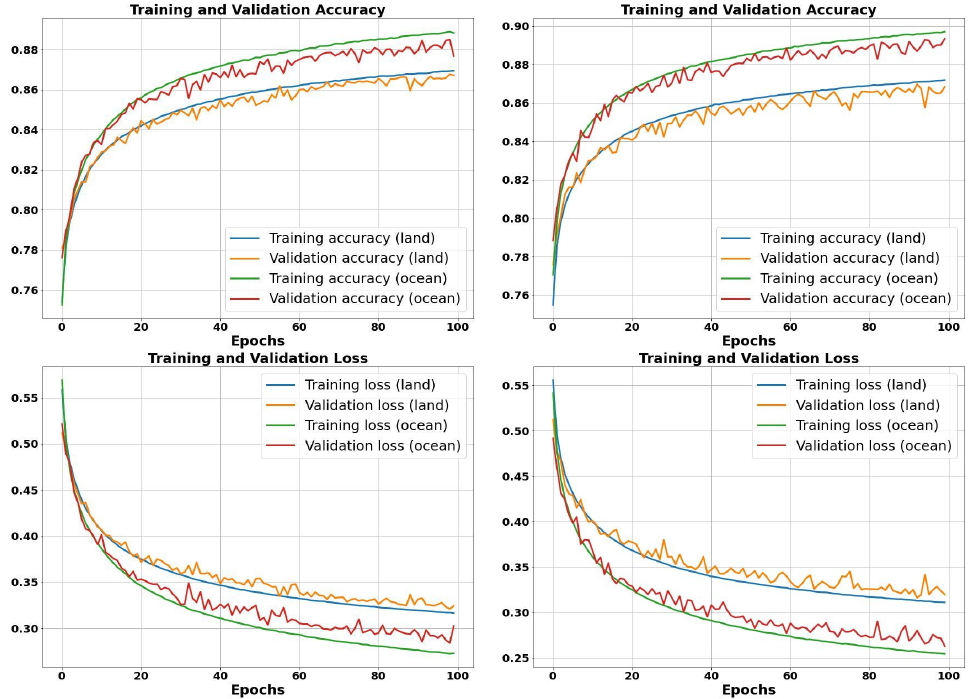
Figure 5. Plots of validation accuracy ( top ) and loss history ( bottom ) in NN training, for ocean and land dataset. ( left panel ): AMSU-A/MHS; ( right panel ): MWS. land dataset. ( left panel ): AMSU-A/MHS; ( right panel ):